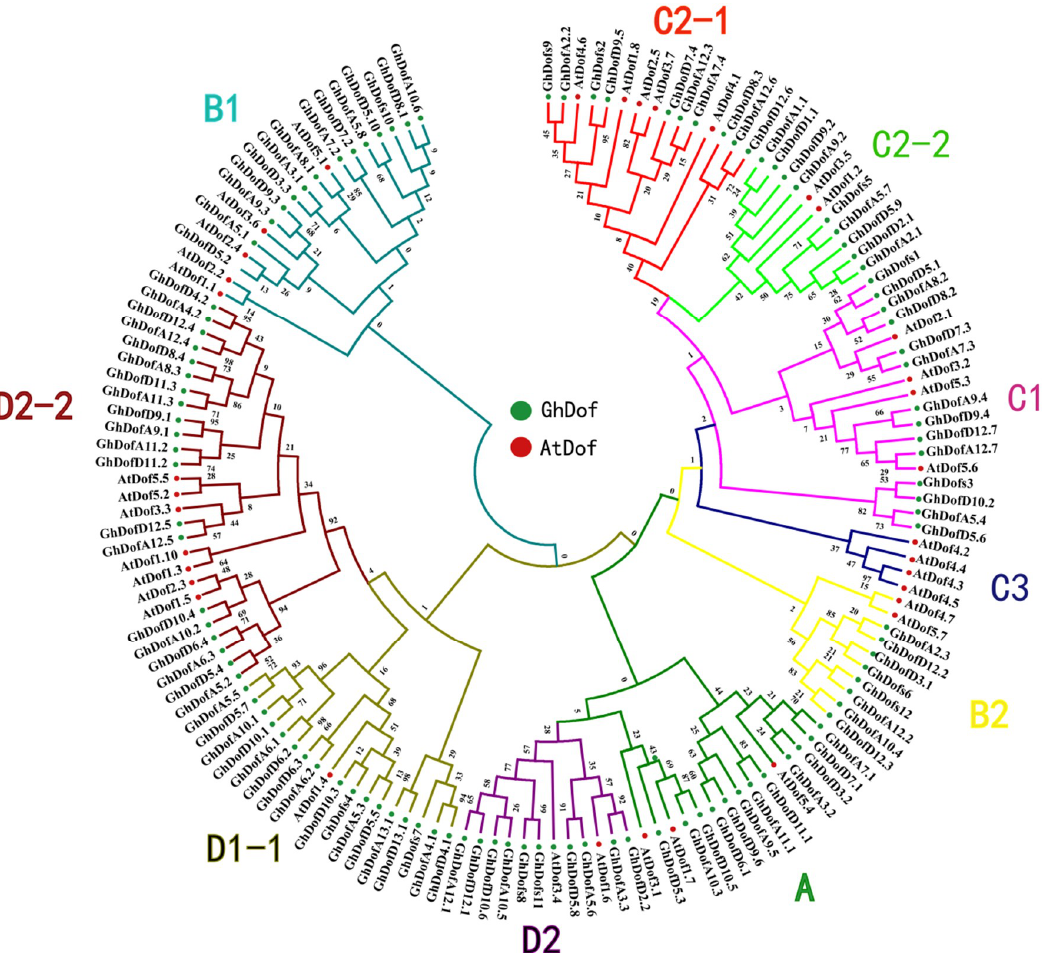
Figure 2. Phylogenetic tree of Dof proteins in G. hirsutum L. and A. thaliana . The full-length amino acid sequences of 114 GhDofs and 36 AtDofs were aligned by ClustalX, and the phylogenetic tree was constructed using MEGA 5.2 by the neighbor-joining method with 1000 bootstrap replicates. Each Dof subgroup is indicated by a specific color.